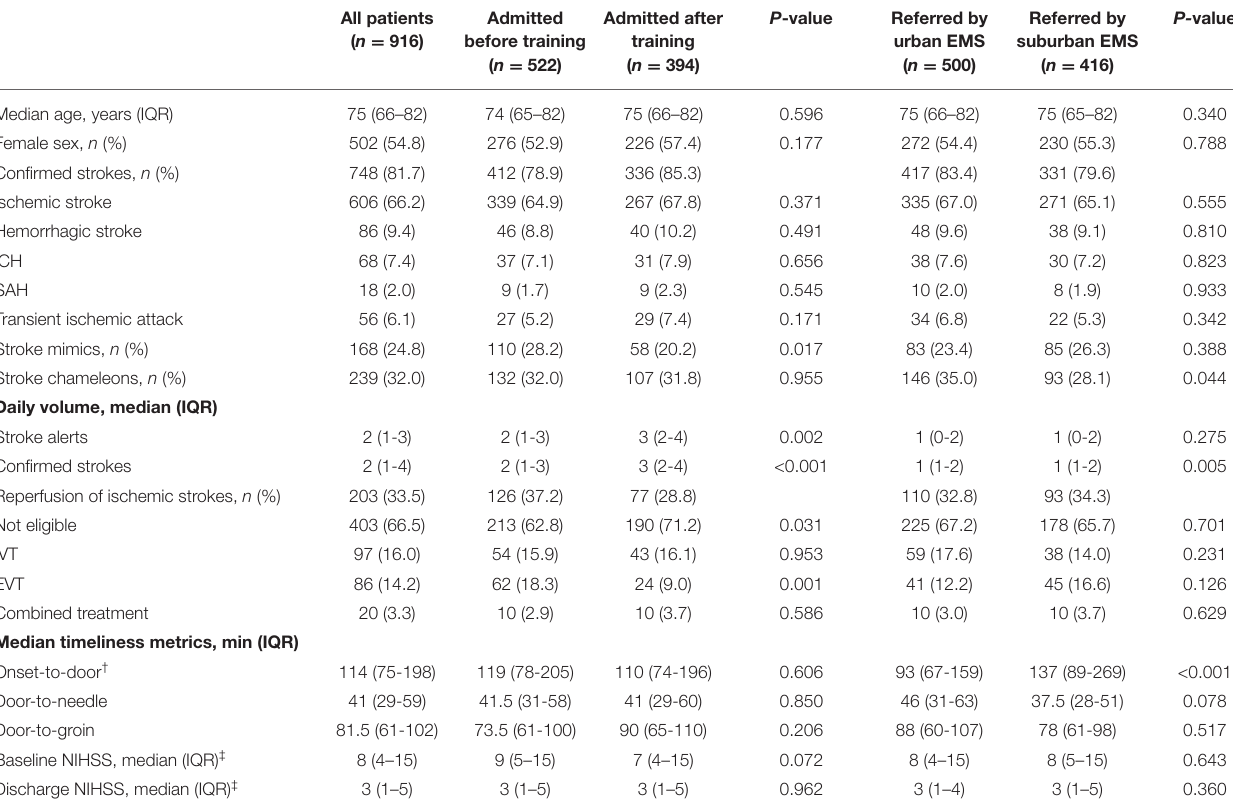
TABLE 1 | Baseline characteristics and outcomes of emergency medical services suspected stroke admissions.